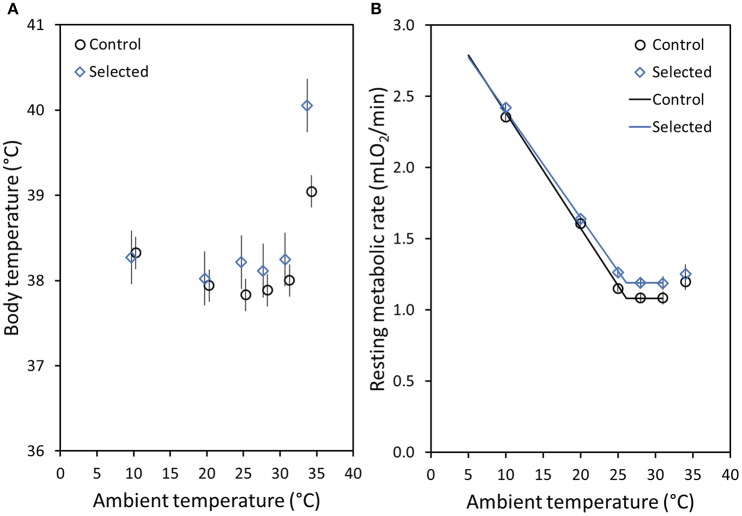
(A) Mean body temperatures (Tbrmr) of bank voles at the time of the lowest measured resting metabolic rate (RMR) at each measurement temperature (Ta) for control (C: black dots) and selected (A: blue diamonds) lines. (B) Mean RMR of bank voles at each measurement Ta for the C (black dots) and the A (blue diamonds) lines. For both figures means are the adjusted least square means (LSM calculated for a fixed body mass, 25 g, and age, 140 days) and the whiskers above and below each mean value represent the standard error (note: for most RMR results the SE range is not visible, because it is smaller than the size of the symbols). The lines on (B) represent the best-fit model, with a common lower critical temperature (LCT = 26.1 ± 0.27°C), but different levels of RMR above LCT (RMRTNZ, for a 25 g vole; A lines: 1.19 mLO2/min, C lines: 1.08 mLO2/min), and different slopes [Ct, for a 25 g vole; A lines: 0.055 mLO2/(min × °C), C lines: 0.061 mLO2/(min × °C)].